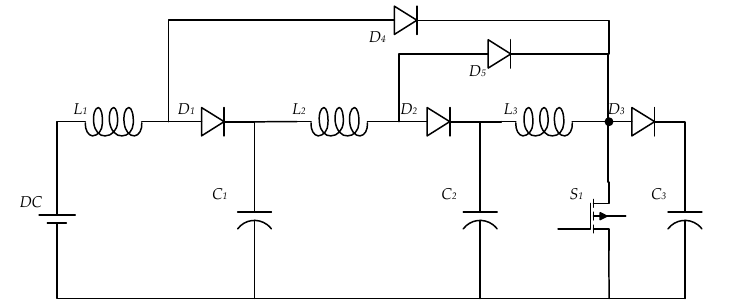
Figure 6. The final simplified synthesized circuit of three-order boost converter.